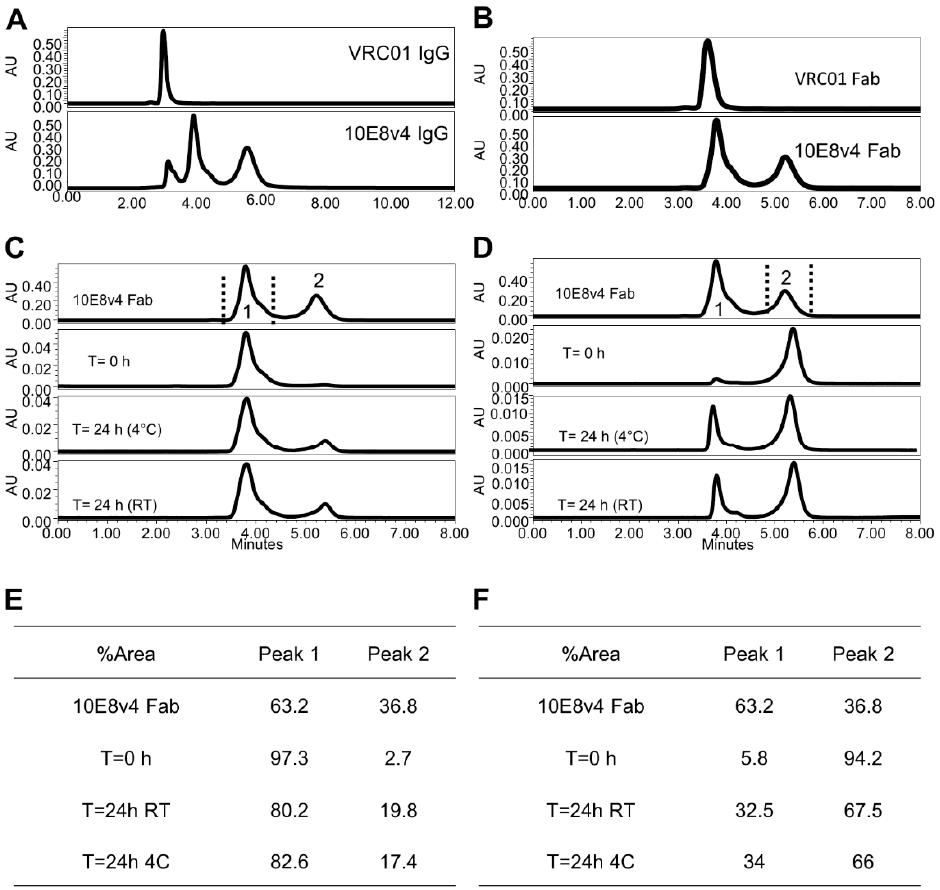
Figure 2. 10E8v4 IgG displays a three-peak profile, whereas Fab displays a two-peak profile. ( A ) Three-peak profile of 10E8v4 IgG with VRC01 as the control. ( B ) Two-peak monomeric population profile of 10E8v4 Fab. ( C ) SEC profile of times-dependent reassortment of 10E8v4 Fab fractionation of Peak 1. ( D ) SEC profile of time-dependent reassortment of 10E8v4 Fab fractionation of Peak 2. ( E ) Tableted redistribution of 10E8v4 Fab Peak 1 fractionation upon injection time and temperature conditions. ( F ) Tableted redistribution of 10E8v4 Fab Peak 2 fractionation upon injection time and temperature conditions.